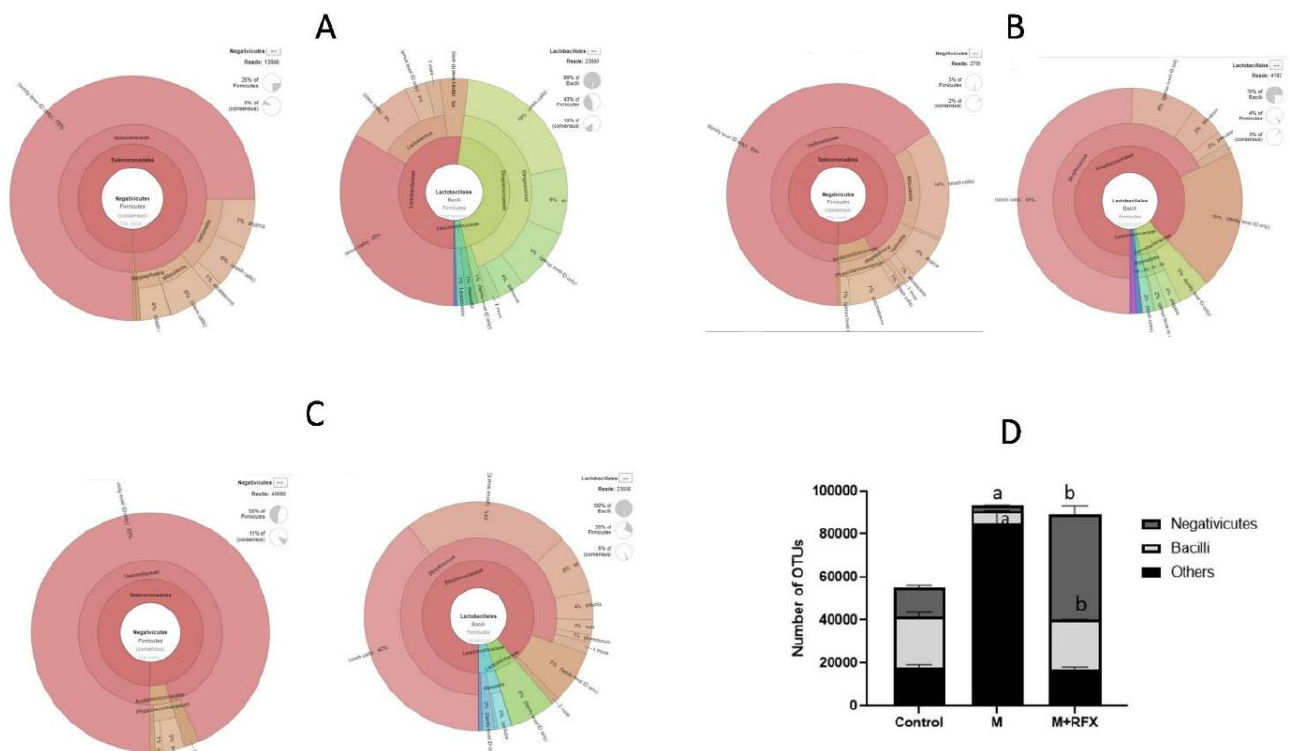
Figure 8. Changes in bacterial classes (Negativicutes and Bacilli) of the phylum Firmicutes after RFX intervention in rats exposed to malathion for four weeks. Krona charts showing Negativicutes and Bacilli levels in the control group ( A ), malathion group ( B ), and malathion+rifaximin group ( C ). ( D ): Representative stacked column for the number of OTUs of significantly changed bacterial classes (Negativicutes and Bacilli) of the phylum Firmicutes in the three rat groups. Data are presented as the means ± SEM. a, significant ( p < 0.05) versus control; b, significant ( p < 0.05) versus the malathion group; data were analyzed with one-way ANOVA followed by Bonferroni-corrected post hoc tests. RFX, rifaximin; M, malathion; M + RFX, malathion and rifaximin.